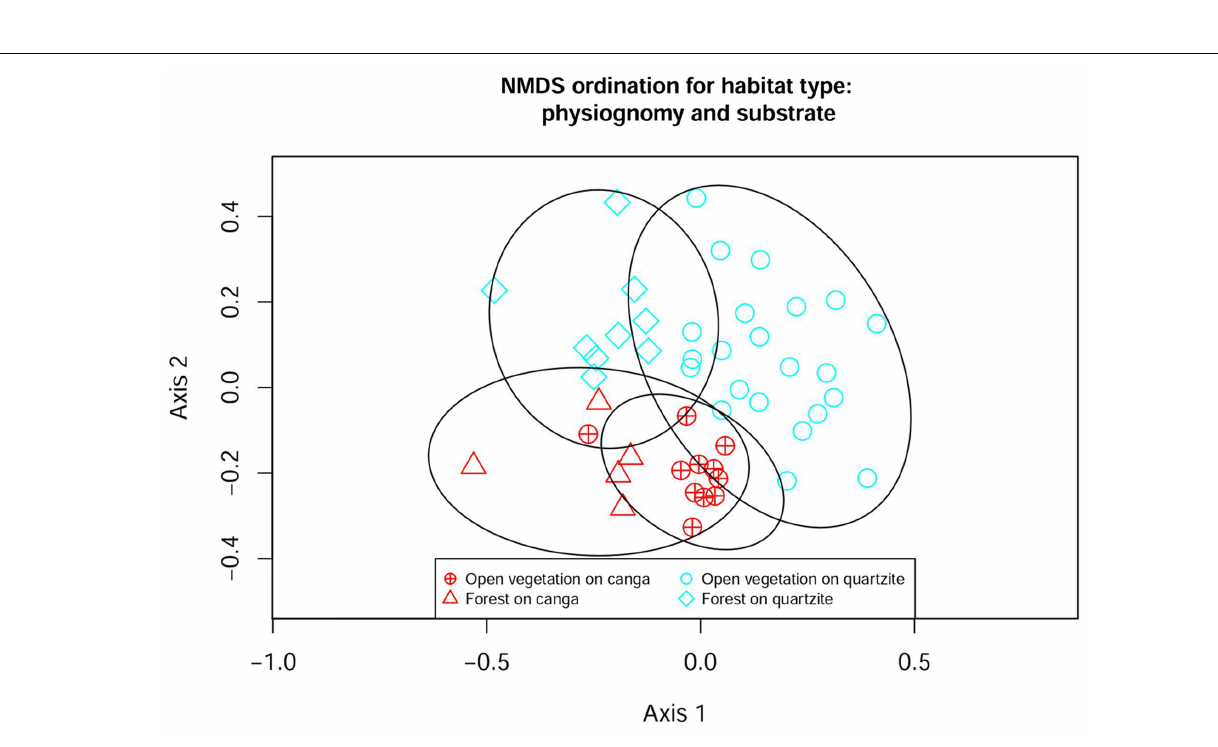
Frontiers in Plant Science |